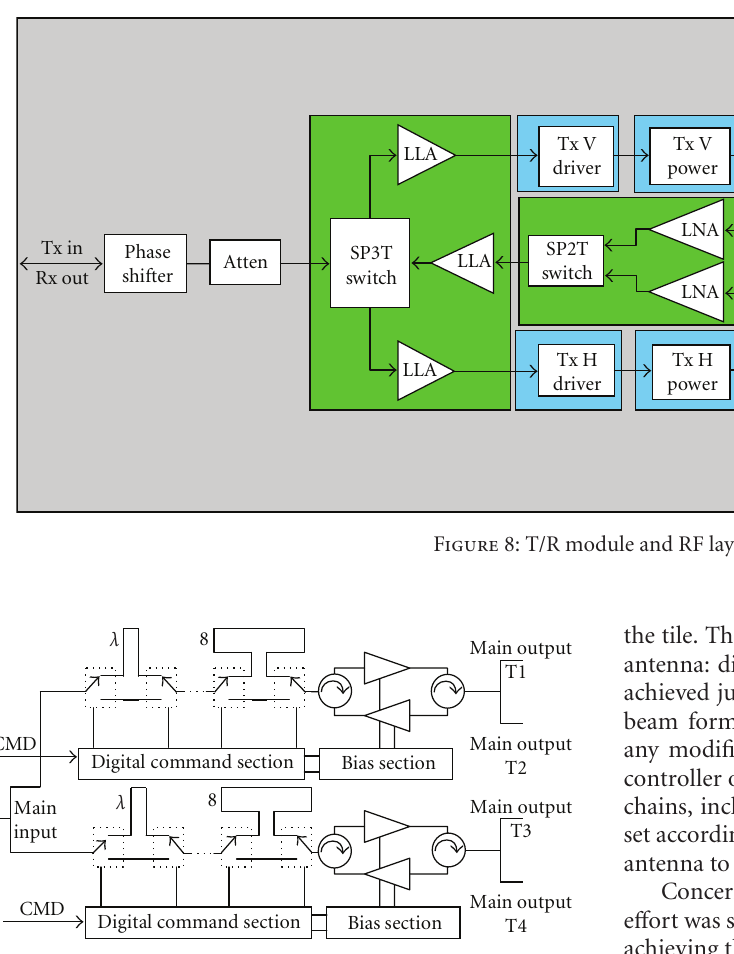
Figure 9: True delay line block